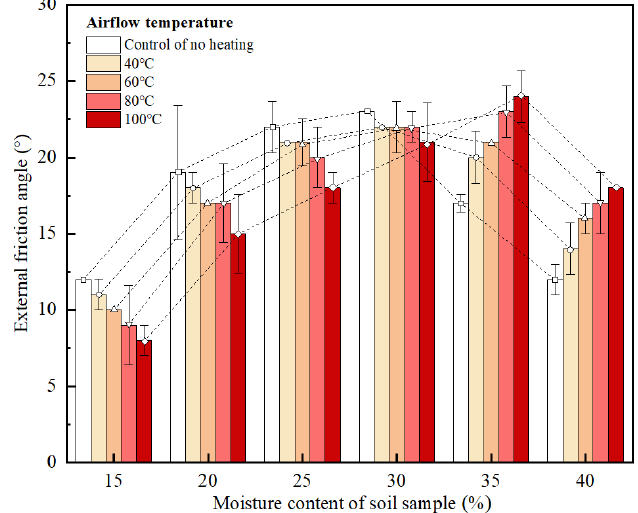
Figure 9. The effect of high-pressure airflow at different temperatures on the external friction angle of soils with different moisture contents. 3.4. Influencing Mechanism of High-Pressure Hot Airflow on the External Friction Angle To further study the mechanism of the reduction in the external friction angle by the high-pressure hot airflow, soil samples with moisture contents of 20%, 30%, and 40% were used. The images of the hot air curtain formed by the high-pressure airflow at different temperatures and the variation in the moisture content of the subsoil were analyzed to understand the influencing mechanism of the subsoil temperature, temperature gradient, and moisture content of the subsoil on the external friction angle. The thermal images of the soil samples are shown in Figure 10 and the effects of sub- soil temperature, temperature gradient, and subsoil moisture content on the angle of ex- ternal friction are shown in Figures 11–13, respectively. The schematic diagram of varia- tions in the moisture content of the subsoils with initial moisture contents of 20% and 30% and heated at 100 °C are shown in Figure 14.